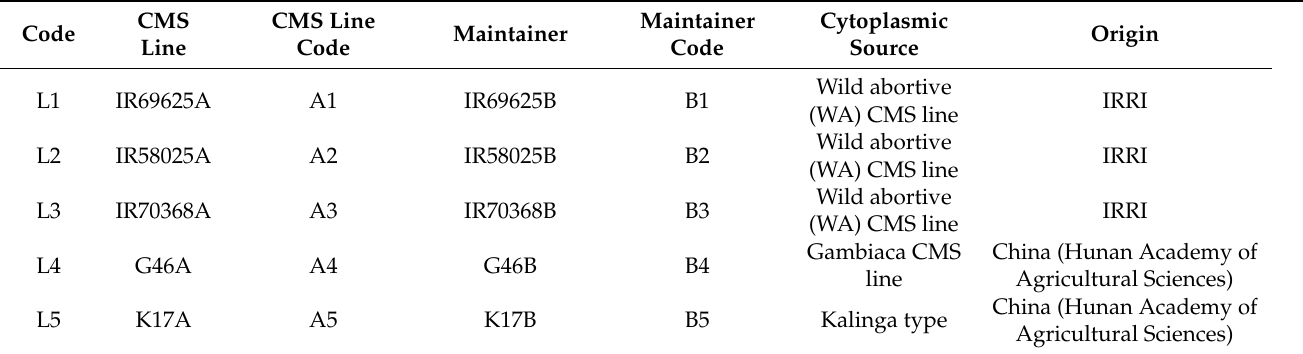
Table 7. Cytoplasmic male sterile (CMS) lines used in the current